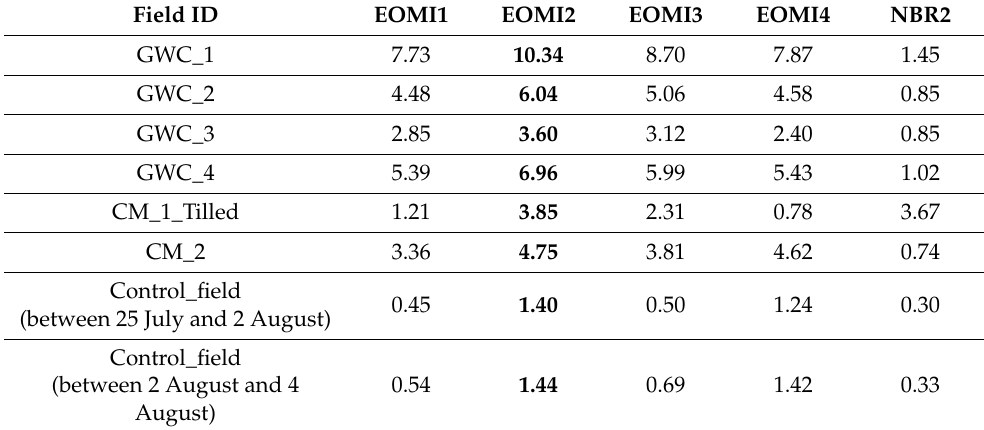
Table 5. Euclidean distances between before and after pixels distribution values of spectral indices for each studied